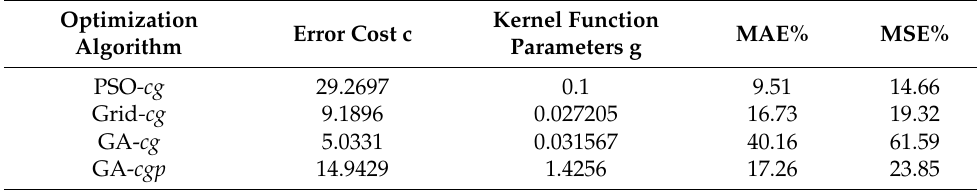
Table 6. Optimal prediction scheme